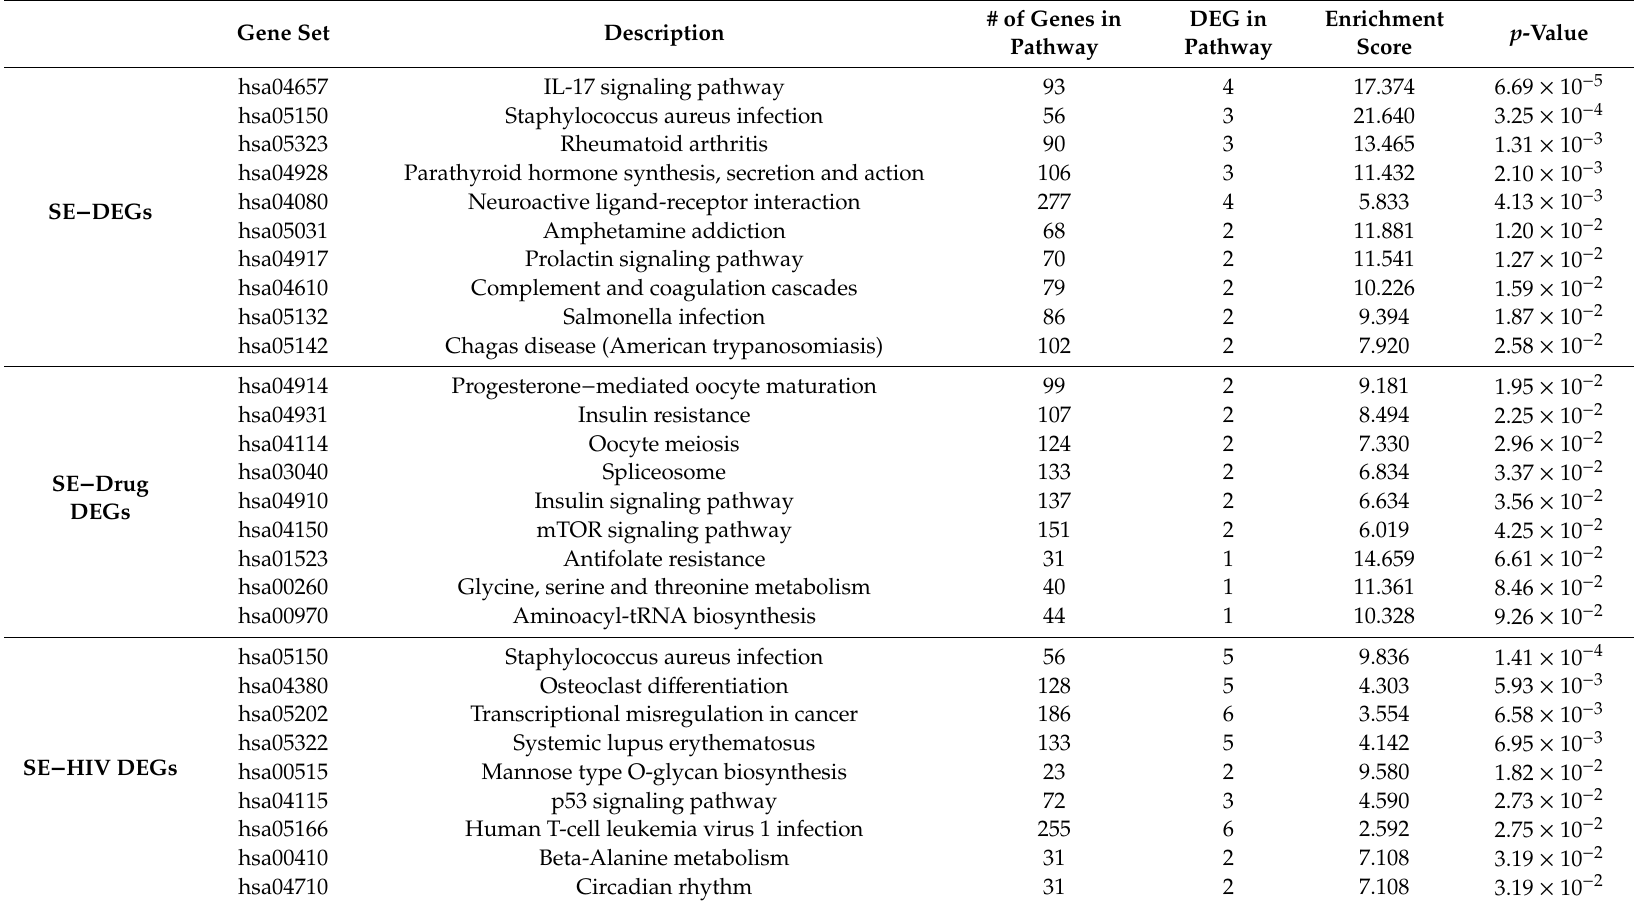
Table 7. Top 10 KEGG pathways from Webgestalt analysis 1